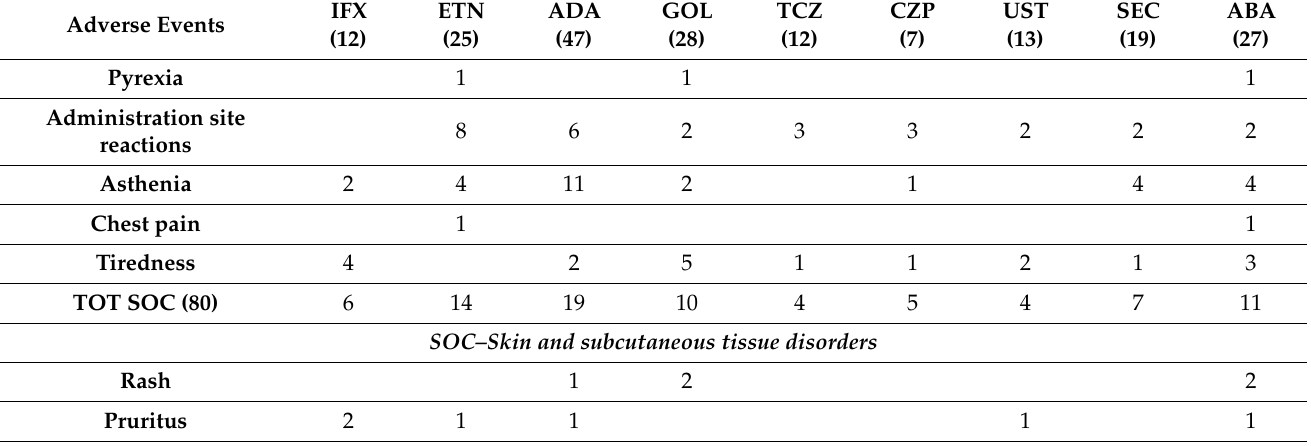
Table 6. SOC-general disorders and administration site